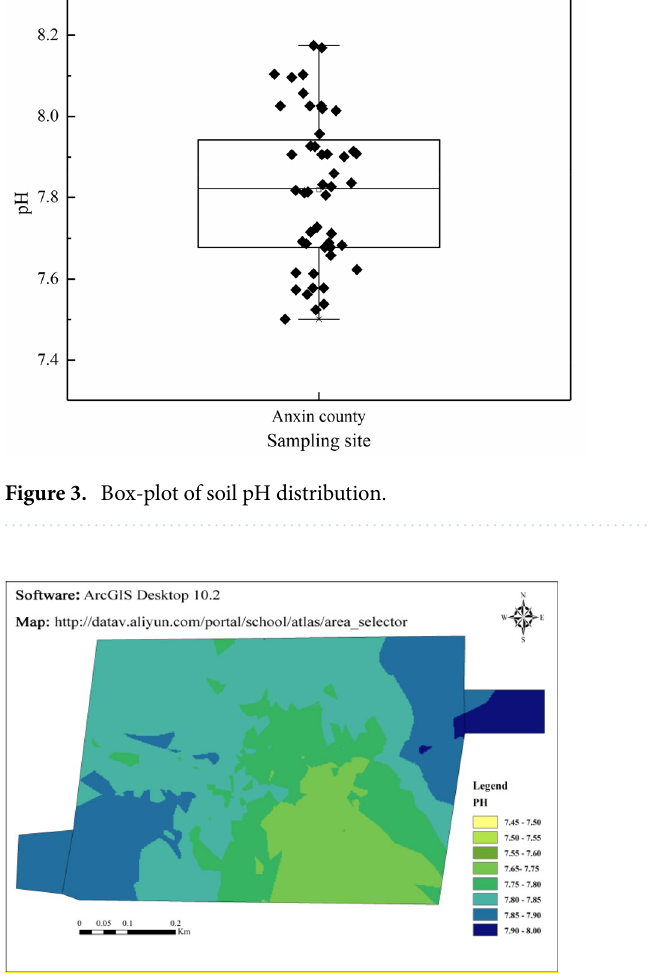
Figure 4. Spatial distribution of soil pH in sampling area.